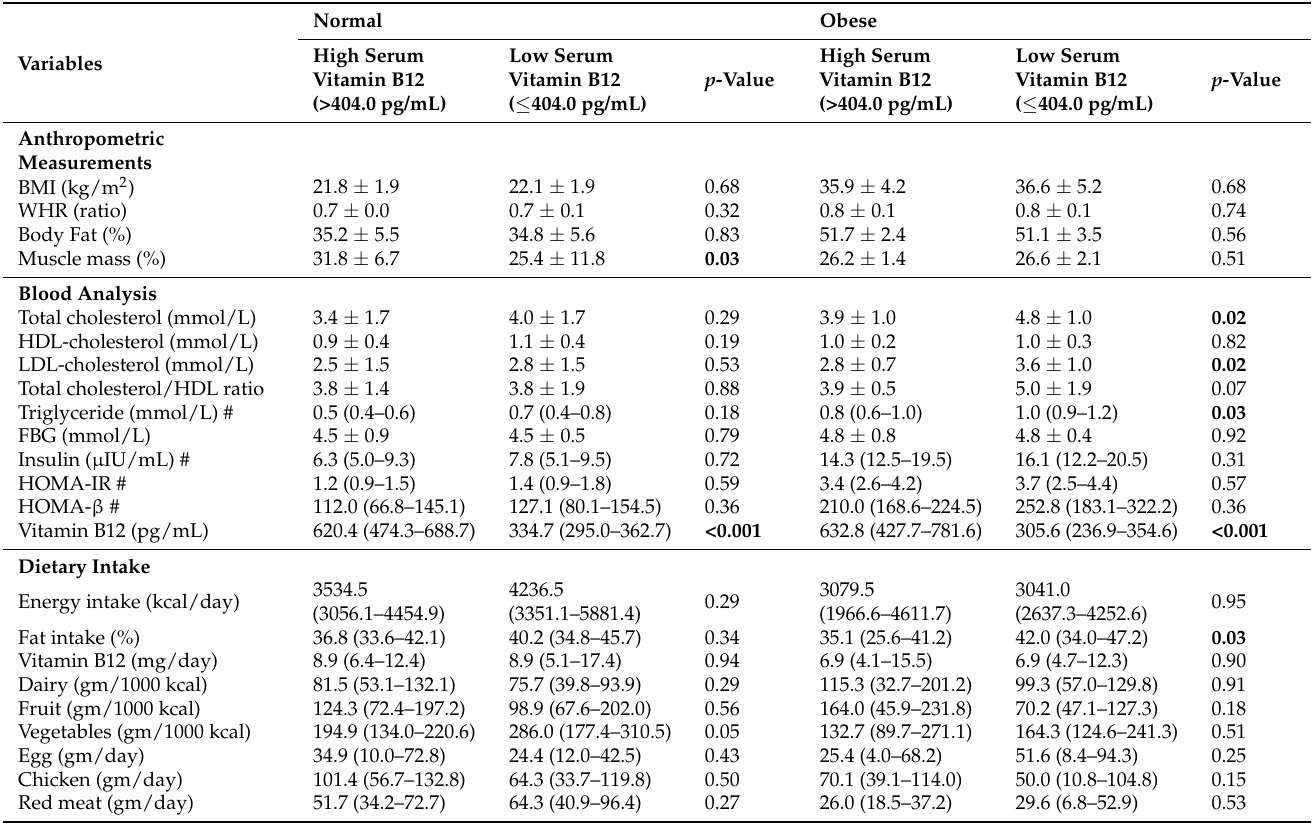
Table 1. Demographic characteristics and other data by serum vitamin B12 levels among normal- weight and obese participants, n =